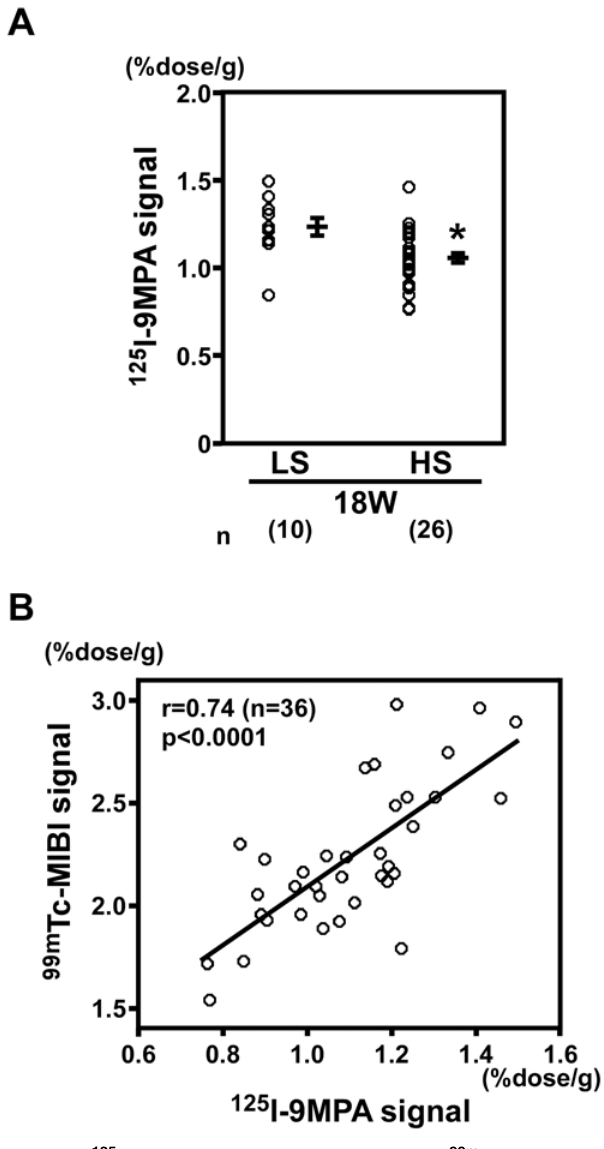
Figure 8. 125 I-9MPA signals and correlation with 99m Tc-MIBI signals. (A) In DS rats fed an HS diet (n = 26), the signals for 125 I-9MPA, an indicator of the activity of mitochondrial β -oxidation, decreased compared with those in DS rats fed an LS diet (n = 10). * P < 0.05 versus LS. (B) 125 I-9MPA signals positively correlated with 99m Tc-MIBI signals (r = 0.74, P < 0.0001, n =